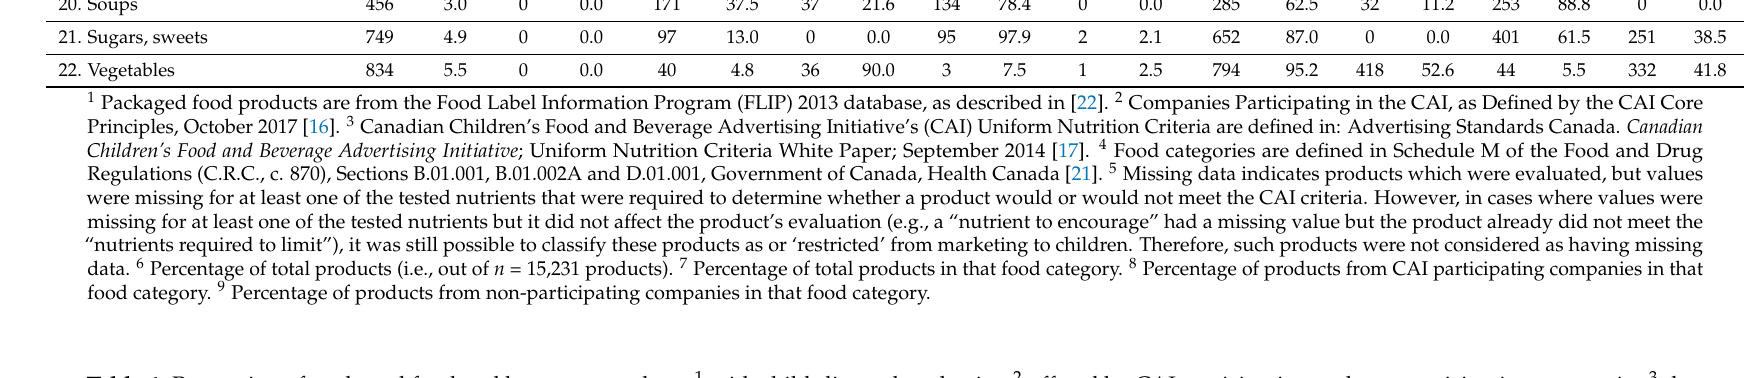
Table 4. Proportion of packaged food and beverage products 1 with child-directed packaging 2 offered by CAI participating and non-participating companies 3